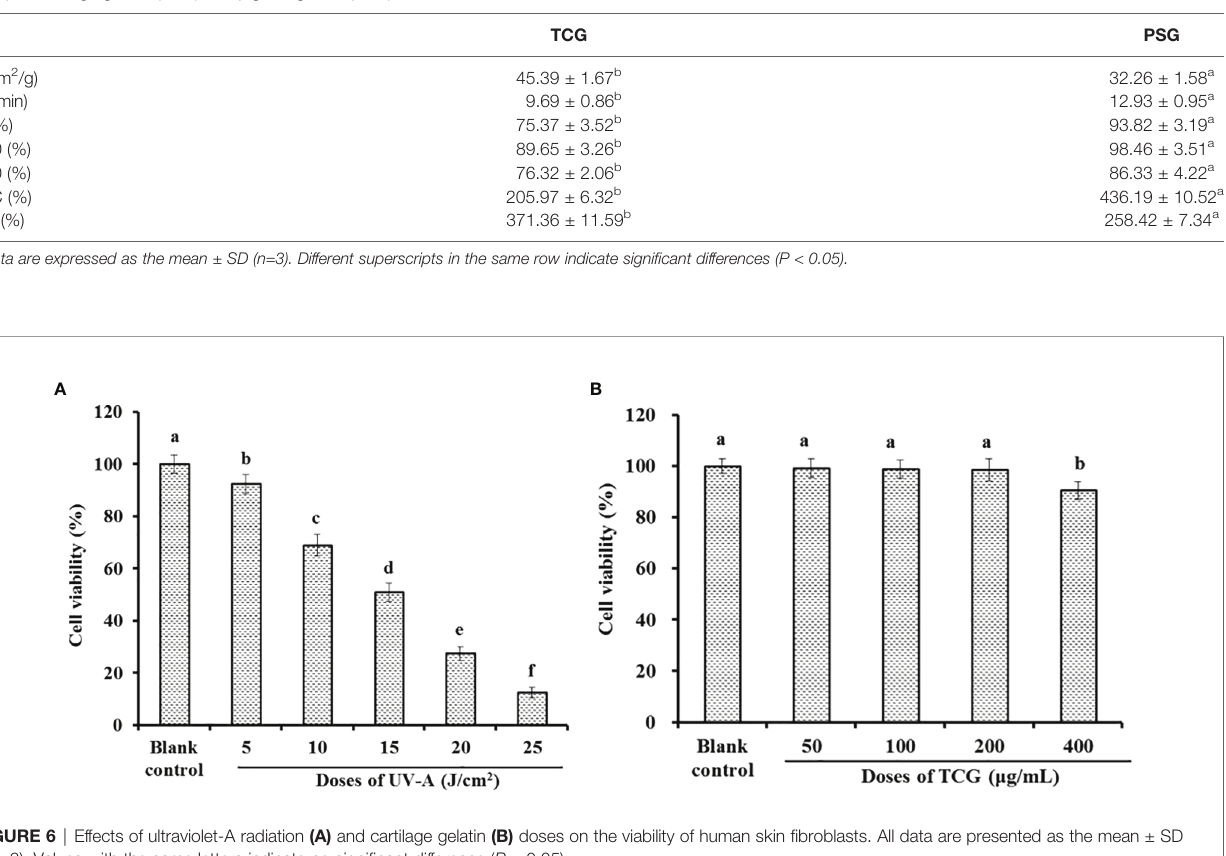
TABLE 4 | Emulsion activity index (EAI), emulsion stability index (ESI), foam capacity (FC), foam stability (FS), fat-binding capacity (FBC), and water-holding capacity (WHC) of cartilage gelatin (TCG) and pigskin gelatin